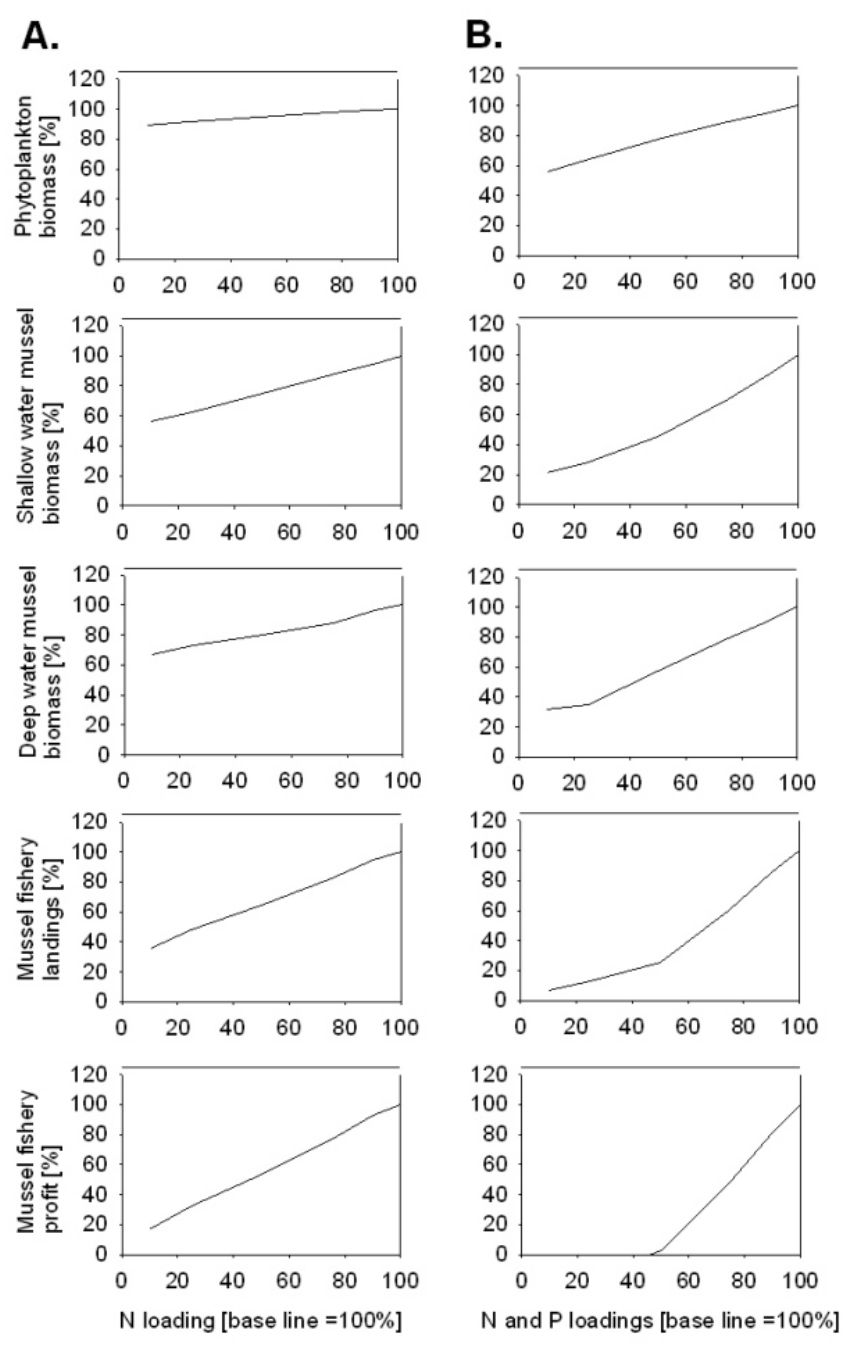
Fig. 5. Results of model simulation of Scenario 1. Impact of percentage reduction of total nitrogen (A) and total nitrogen and phosphor (B) relative to the annual averages from 1985-2003 of (from top to bottom) phytoplankton concentration, mussel biomass in shallow and deep waters, mussel landings, and mussel fishery profit. The baseline is 100% loading, corresponding to the average from 1985-2003 (Table